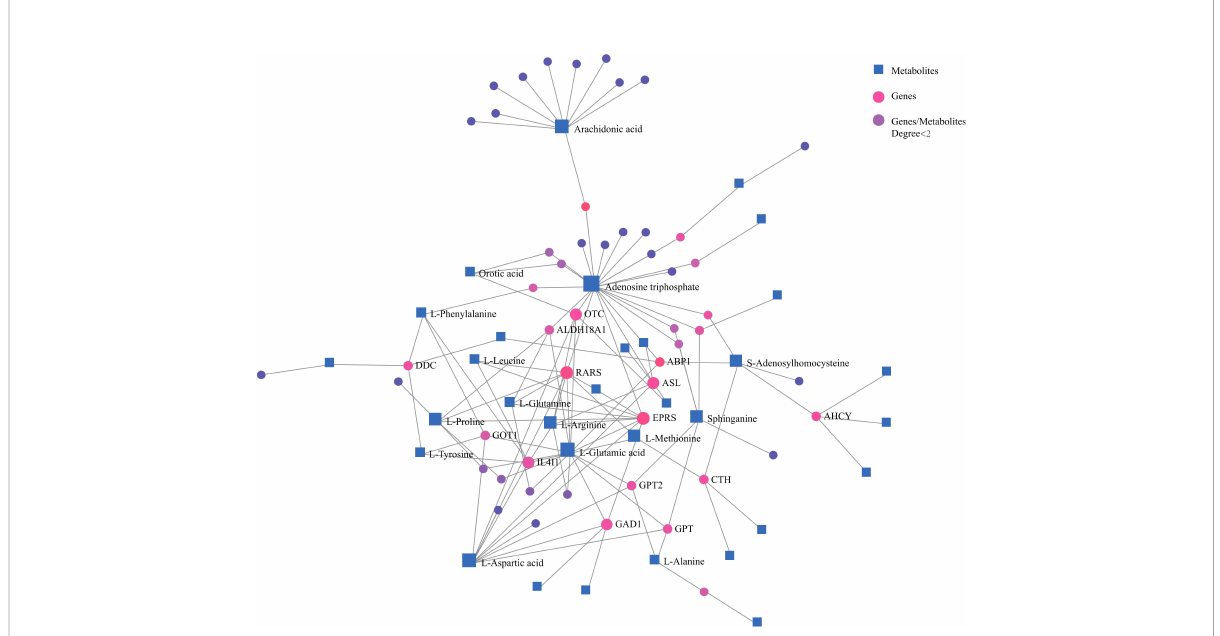
FIGURE 3 Network analysis of signi fi cantly changed metabolites and genes that are involved in key metabolic pathways. Blue square, metabolites; pink dot, genes; purple dot, genes or metabolites that did not have close relationships with others were